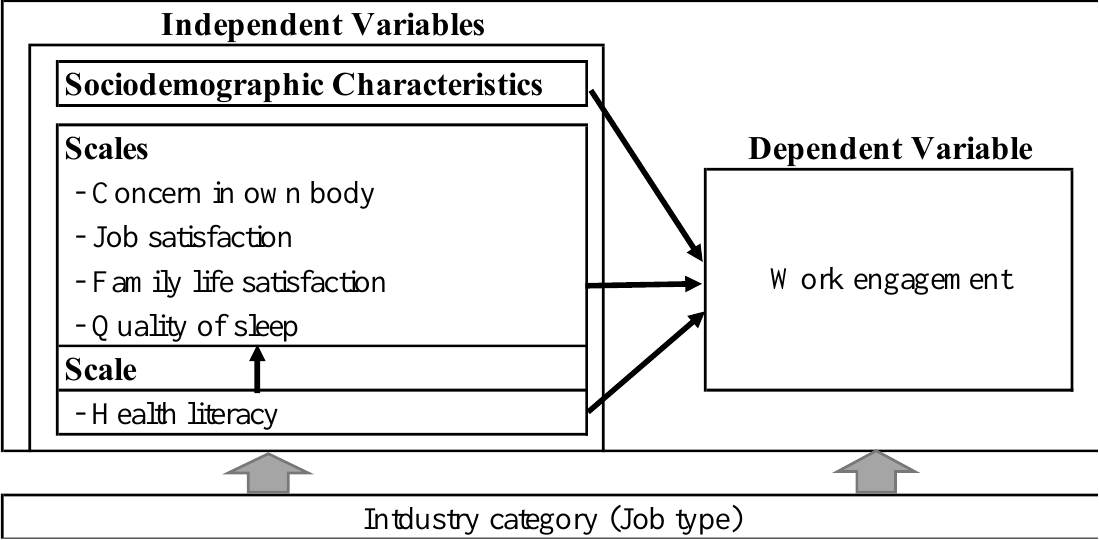
Figure 1. A Conceptual framework of this study.